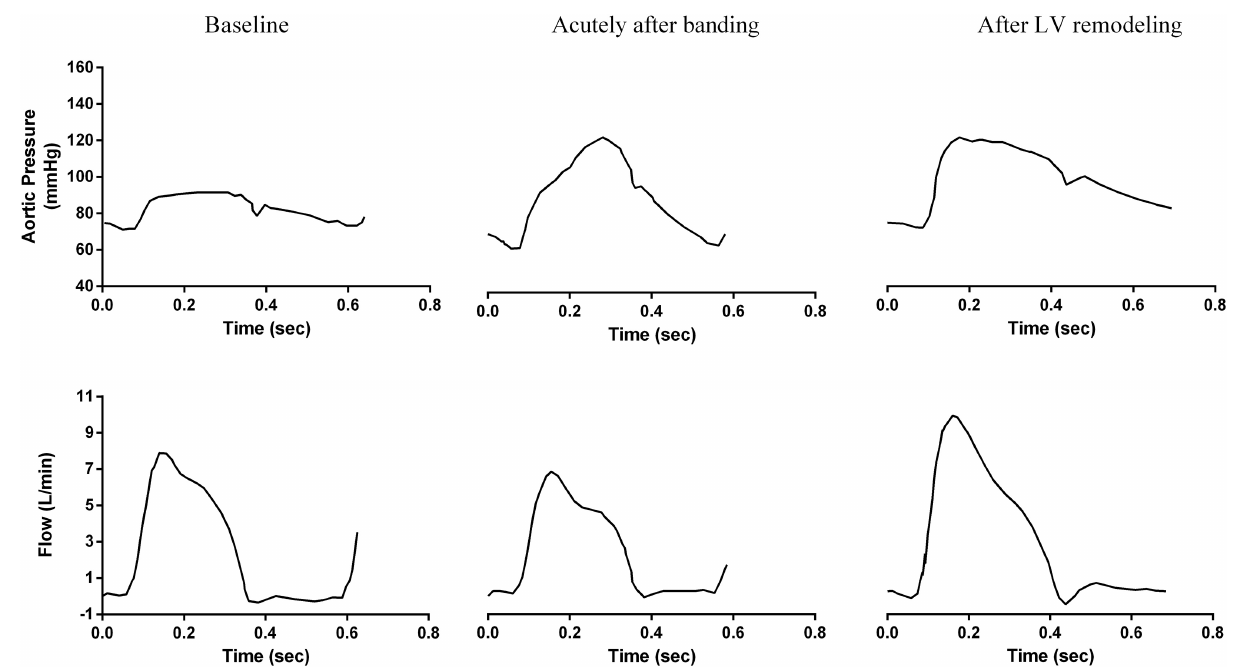
FIGURE 1 | Acute and long-term changes of central aortic pressure and flow due to aortic banding as measured invasively by Ioannou et al. (2009) in the swine. Figure reproduced with permission. TABLE 1 | Simulation parameters for baseline, acutely after banding, and after LV remodeling. Parameter Baseline Banding LV remodeling Ees (mmHg/mL)